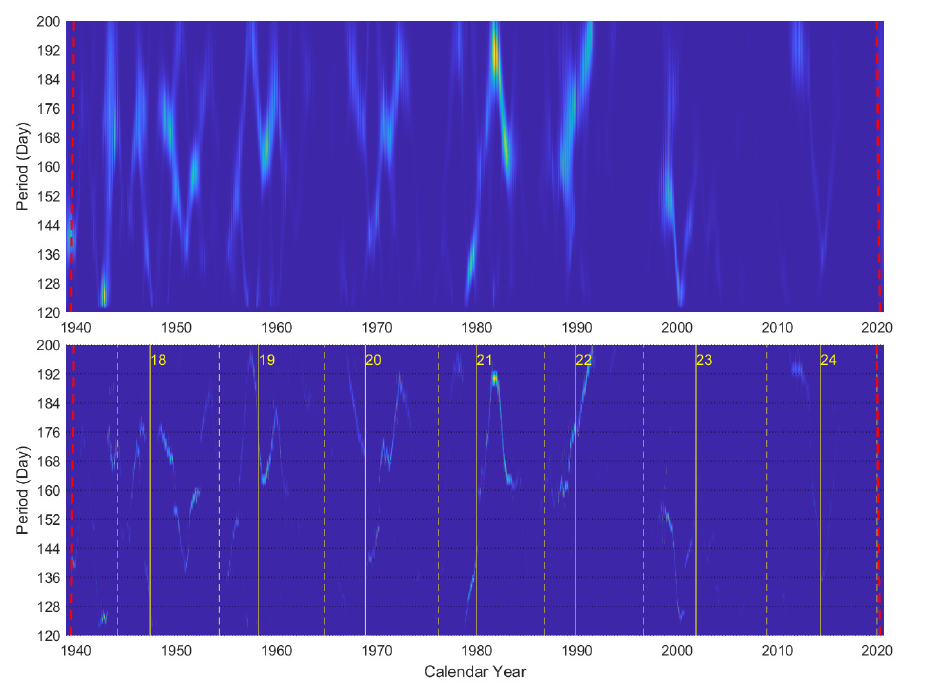
Figure 12. Same as Figure 6, but for periods between 120 and